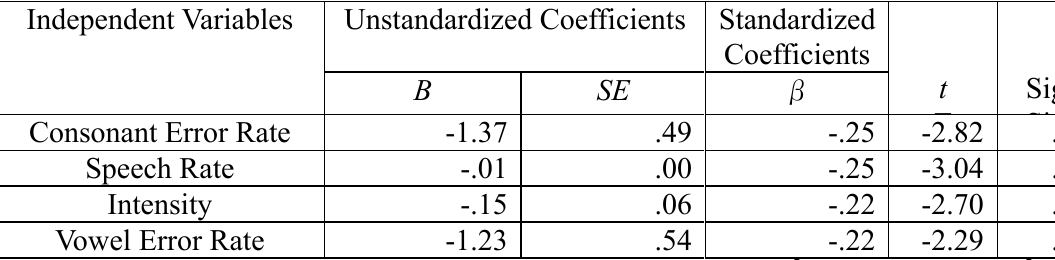
Stepwise Multiple Regression Analysis between Accentedness Ratings and Seven Speech Characteristics (American Judges)